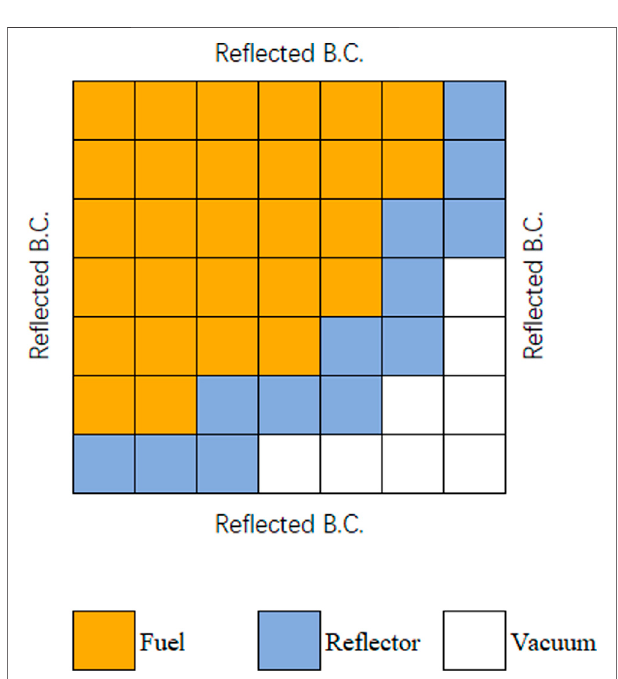
FIGURE 2 | Geometry of the simpli fi ed PWR.